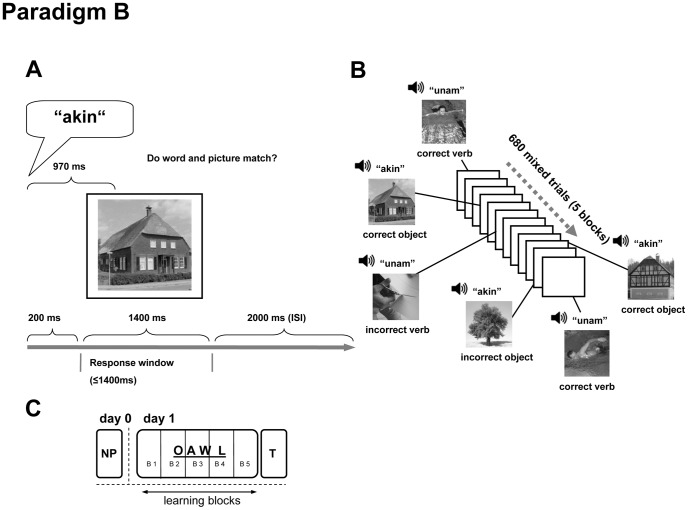
Design of Paradigm B.A Paradigm B single trial layout. Like in Paradigm A each trial is composed of one pseudoword in connection with a picture. Important change in Paradigm B is the occurrence of objects intermixed with actions (50% objects). B Paradigm B trial sequence during a learning session. Pseudowords are coupled with different pictures of actions and objects. Correct couplings appear more often than incorrect couplings (for details see text). C Timeline of Paradigm B Paradigm B consists of one single session, divided into five blocks and followed by the translation test. NP: neuropsychological evaluation OAWL: object and action word learning T: translation B: Block ISI: Interstimulus Interval.